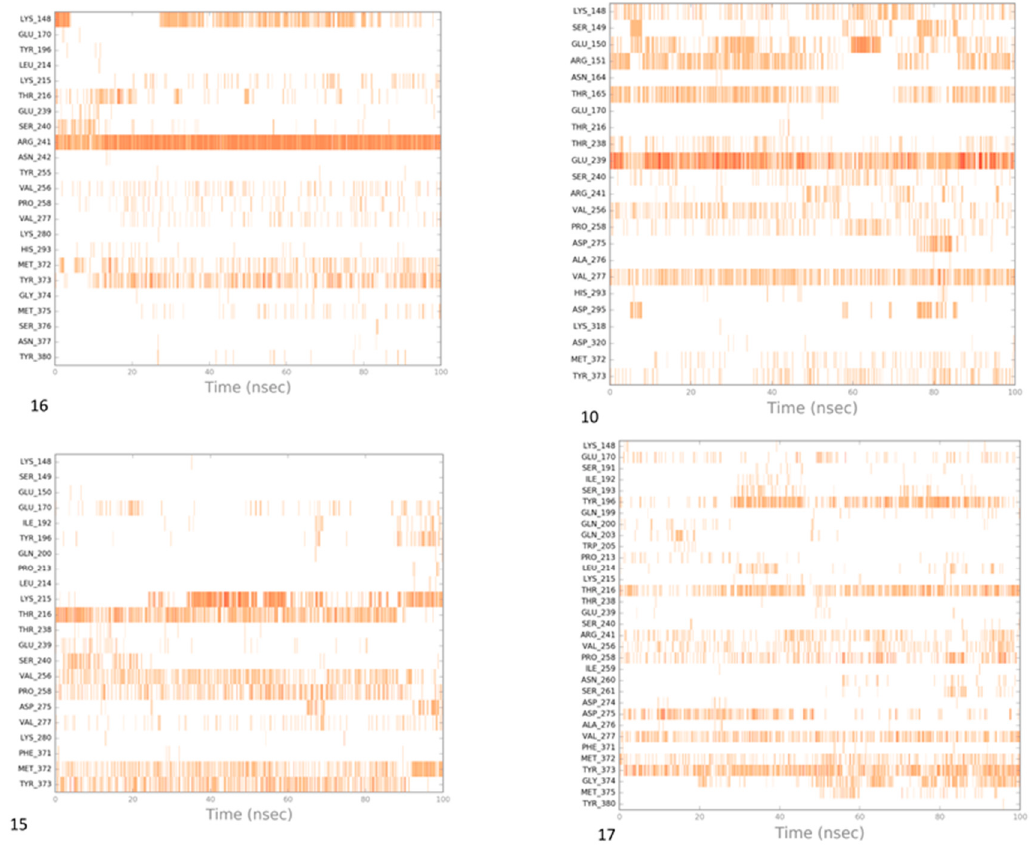
Figure 9. Ligand–protein interaction diagrams obtained for PBP2a allosteric site during molecular dynamic simulations for compounds 16 , 10 , 15 and 17 .